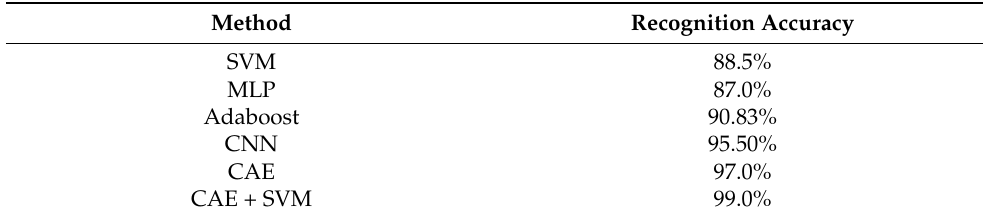
Table 2. Target recognition results with different methods (T72_BMP2_BTR70 dataset).